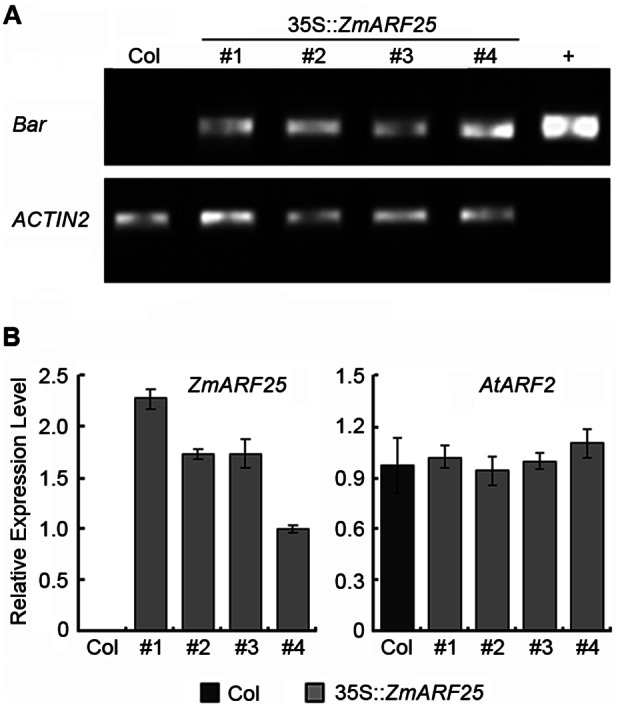
Overexpression of ZmARF25 in Arabidopsis.(A) The genomic PCR results for four homozygous T3 transgenic plants (35S::ZmARF25 #1–4) using Bar gene specific primer. PCR products were determined visually by running on 1% agarose gel and stained by Ethidium bromide. Col represents wild-type and #1–4 represent 35S::ZmARF25 transgenic lines, which is the same in Figure 3B; “+” represents the recombinant plasmid. (B) Relative expression levels of ZmARF25 gene in four homozygous T3 transgenic lines. Total RNA was isolated from the 30-day-old aerial of Arabidopsis. Data are represented as the mean ± SE (n = 3). ACTIN2 was used as an endogenous control.